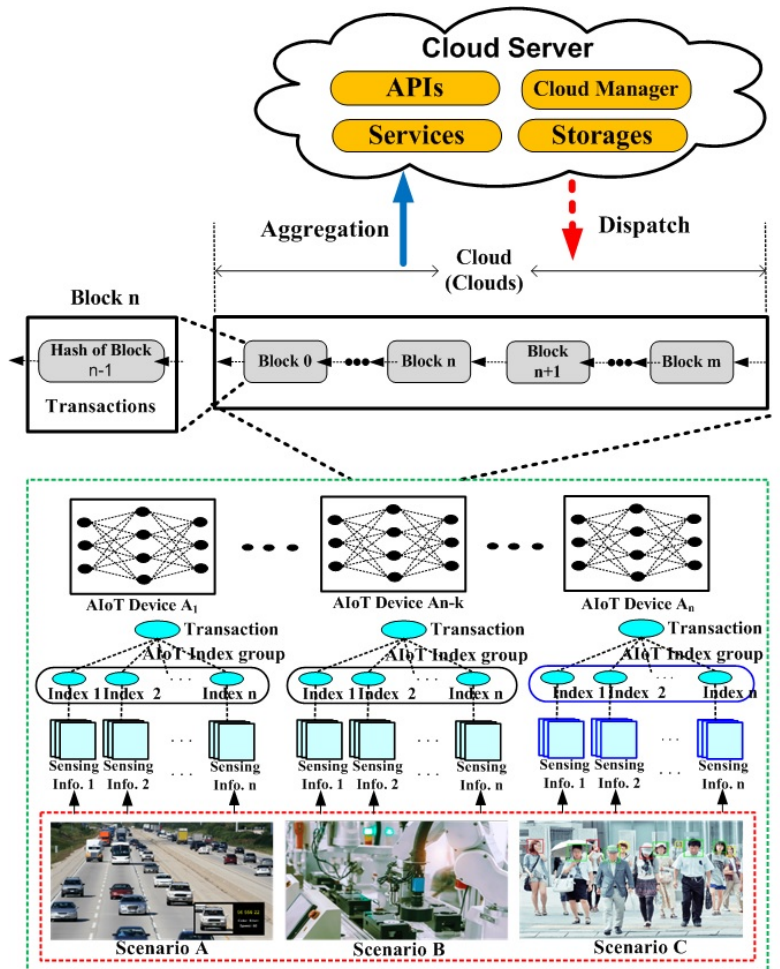
Figure 5. IoT block processing for hash